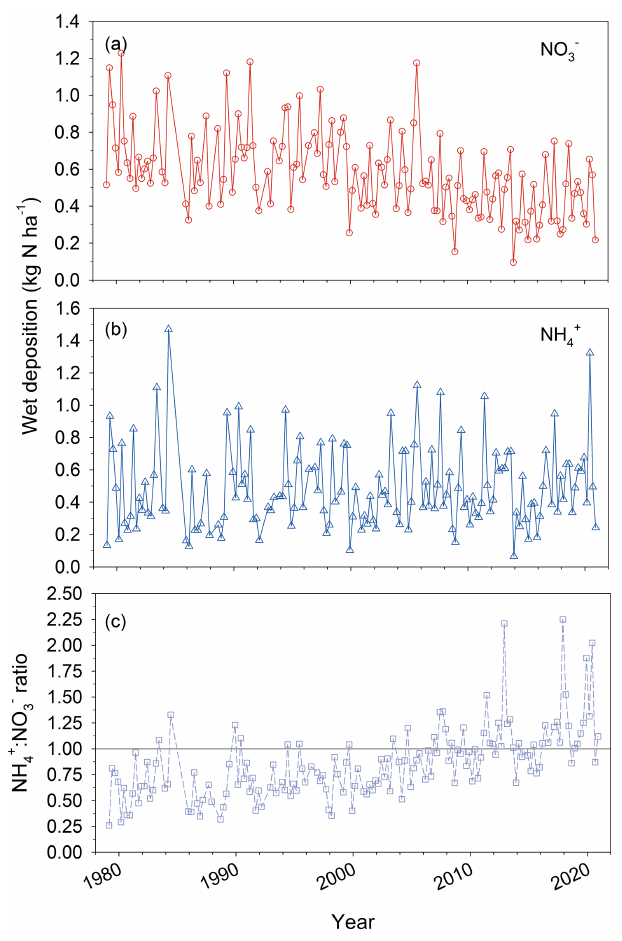
Figure 3. Long-term NTN NC25 measurements of seasonal (a) and NO − (b) wet deposition along with the ratio of NH + NH + 4 3 to NO − as nitrogen and a 1:1 reference line (c) . 3